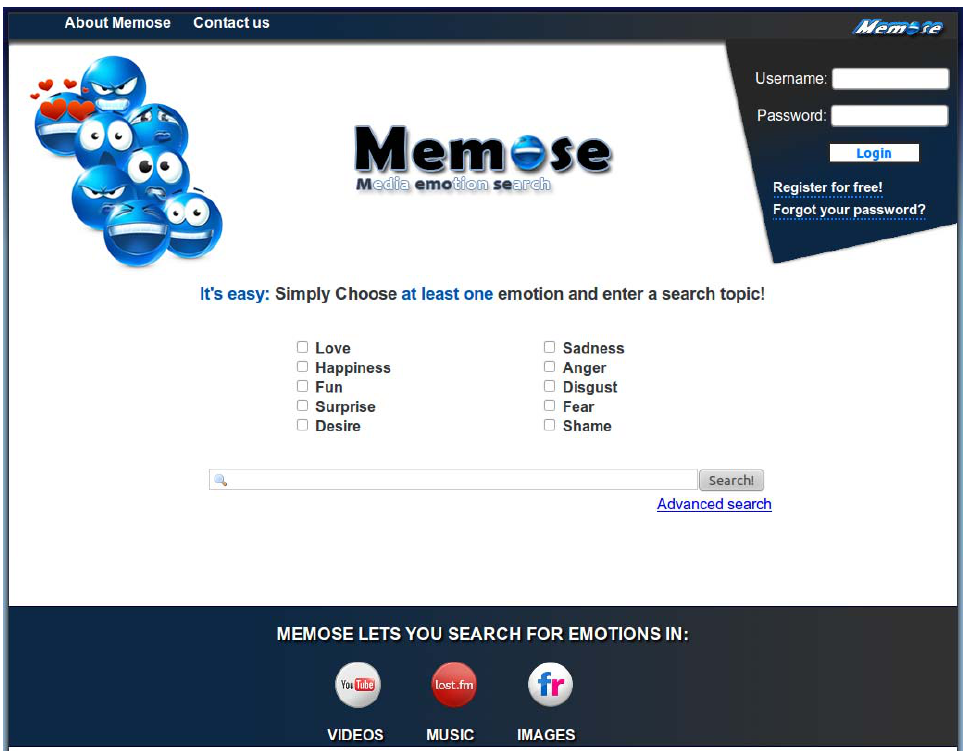
Figure 3. The MEMOSE search